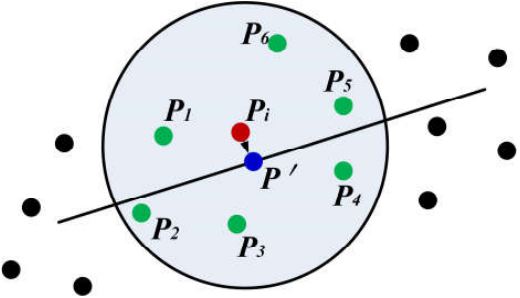
Figure 12. Diagram of the operating principle of the local point straight-line normalization smoothing algorithm (the black points, the green points and the red point are the points before smoothing, and the blue point is the point after smoothing).